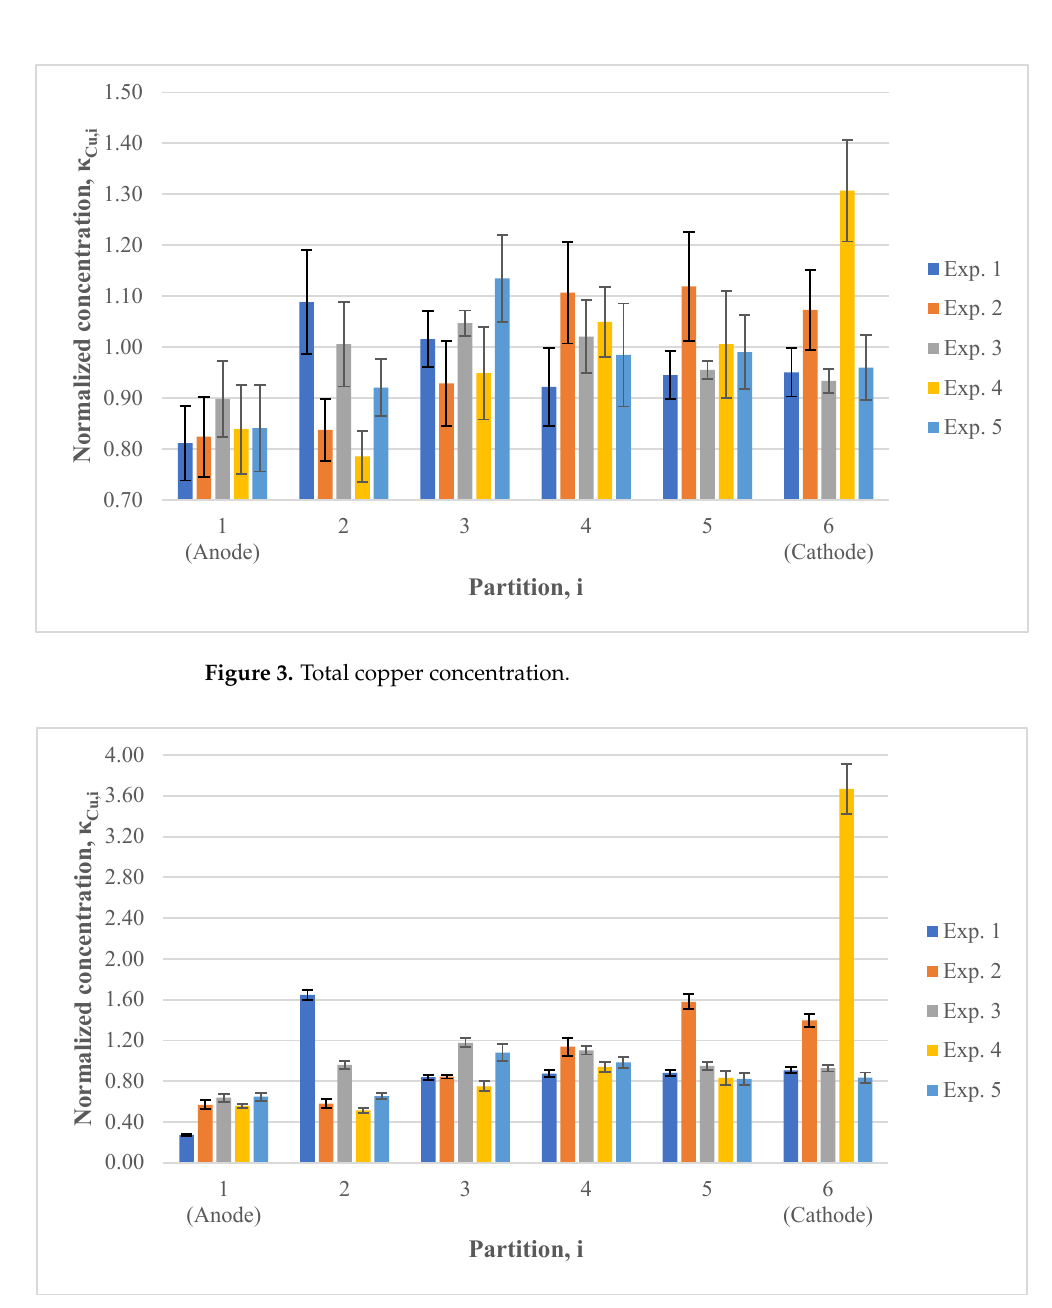
Figure 4. Soluble copper concentration.